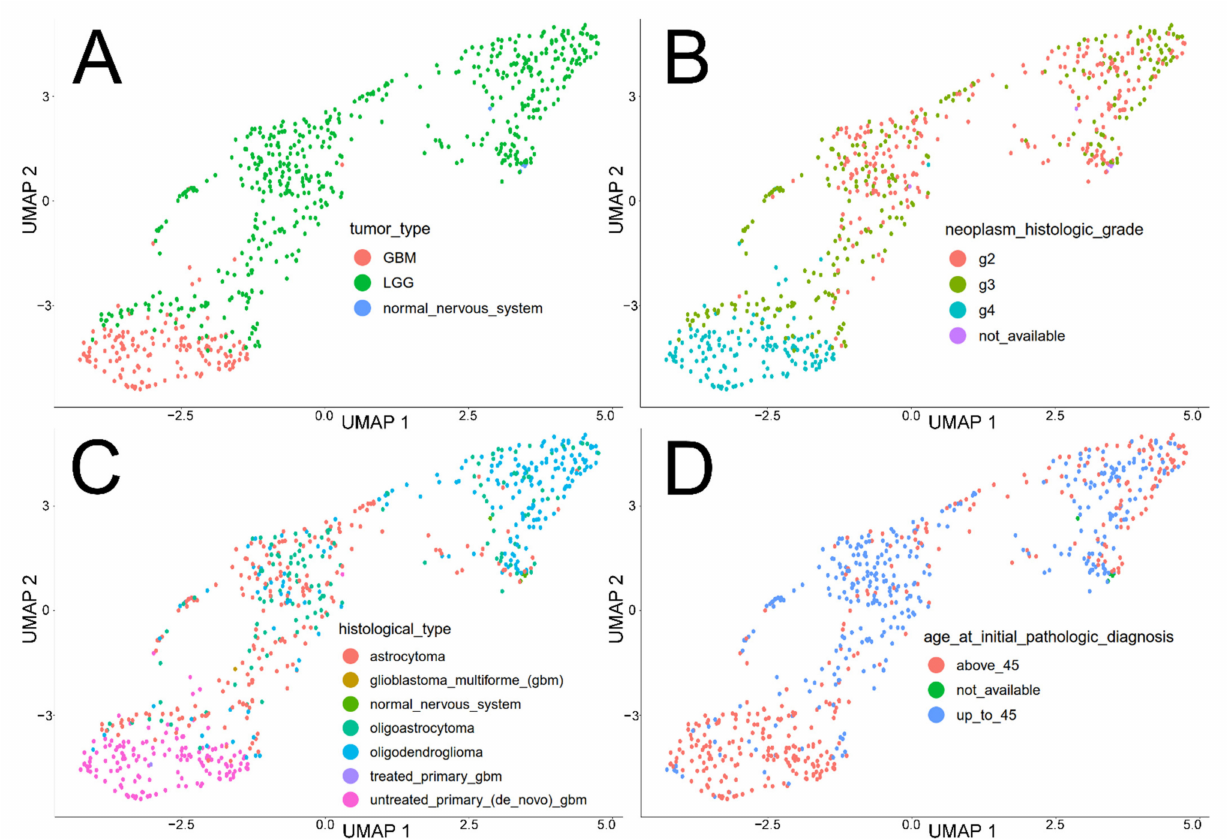
Figure 2. Global profiling of TCGA glioma samples with normal brain tissue through various clinical data. ( A ) tumor_type (specific cancers and corresponding normal tissue). ( B ) neoplasm_histologic_grade . ( C ) histological_type . ( D ) age_at_initial_ pathologic_diagnosis